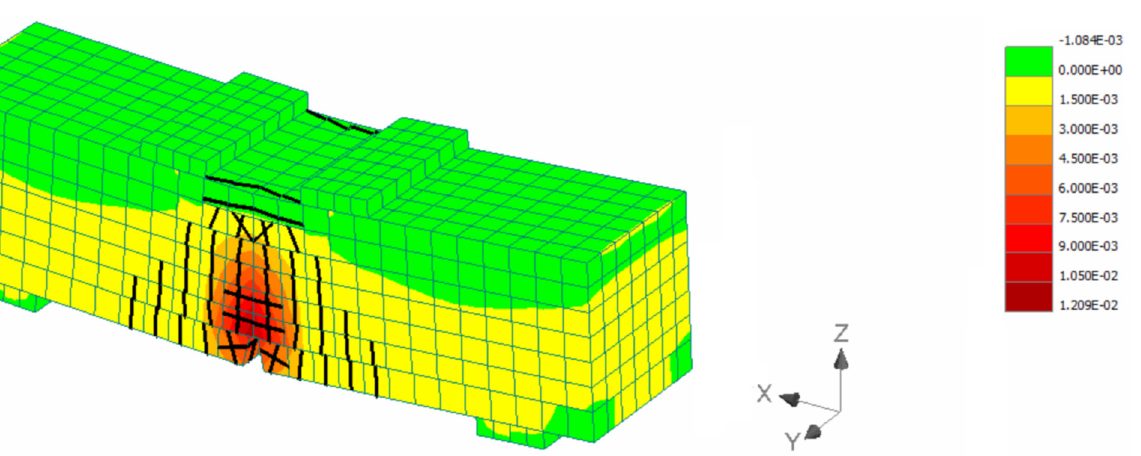
Figure 12. Constitutive model for the tensile stress–strain model of SFRCC. Adapted from [9]. For the inverse analysis, the flexural tests results presented in Section 3.1.2 were used. Numerical models were developed to simulate the response of the prisms and analyses were conducted using the model presented in Figure 13 considering different tensile strength values (0.4, 0.6, 0.8, 1.0 MPa). Indicative strain distribution at the maximum load stage for the prism with 0.8 MPa tensile strength is presented in Figure 13. The black lines indicate the crack development while the strain contours represent the strain distribution along the prism span. The maximum compressive strain at the maximum load stage was found at the top of the prism and it was equal to 1%, while the respective maximum tensile strain at the bottom of the prism was 12%.